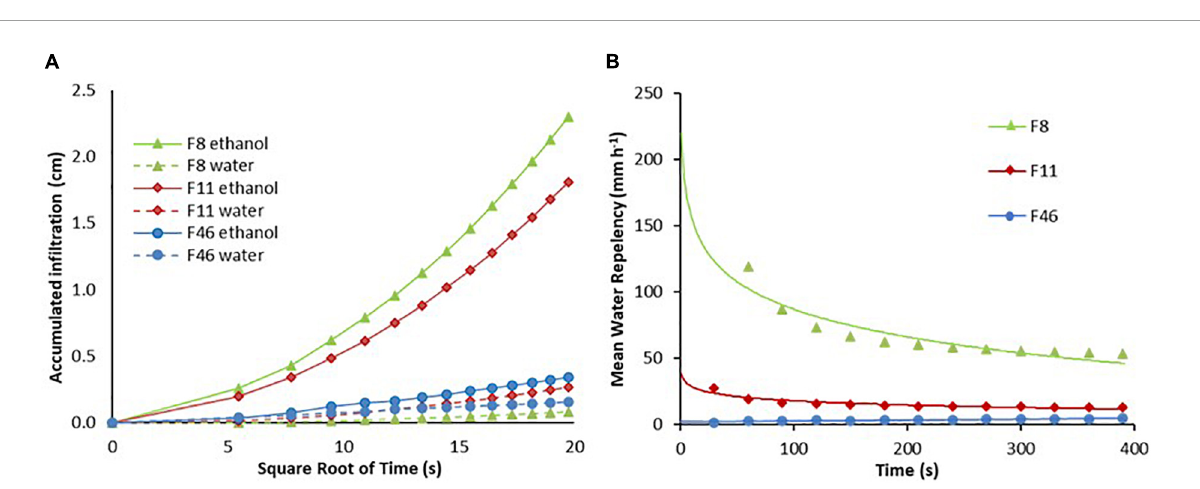
FIGURE5 Accumulated infiltration with water and ethanol (A) and water repellency (B) for initial (F8, F11) and advanced (F46) passive restoration